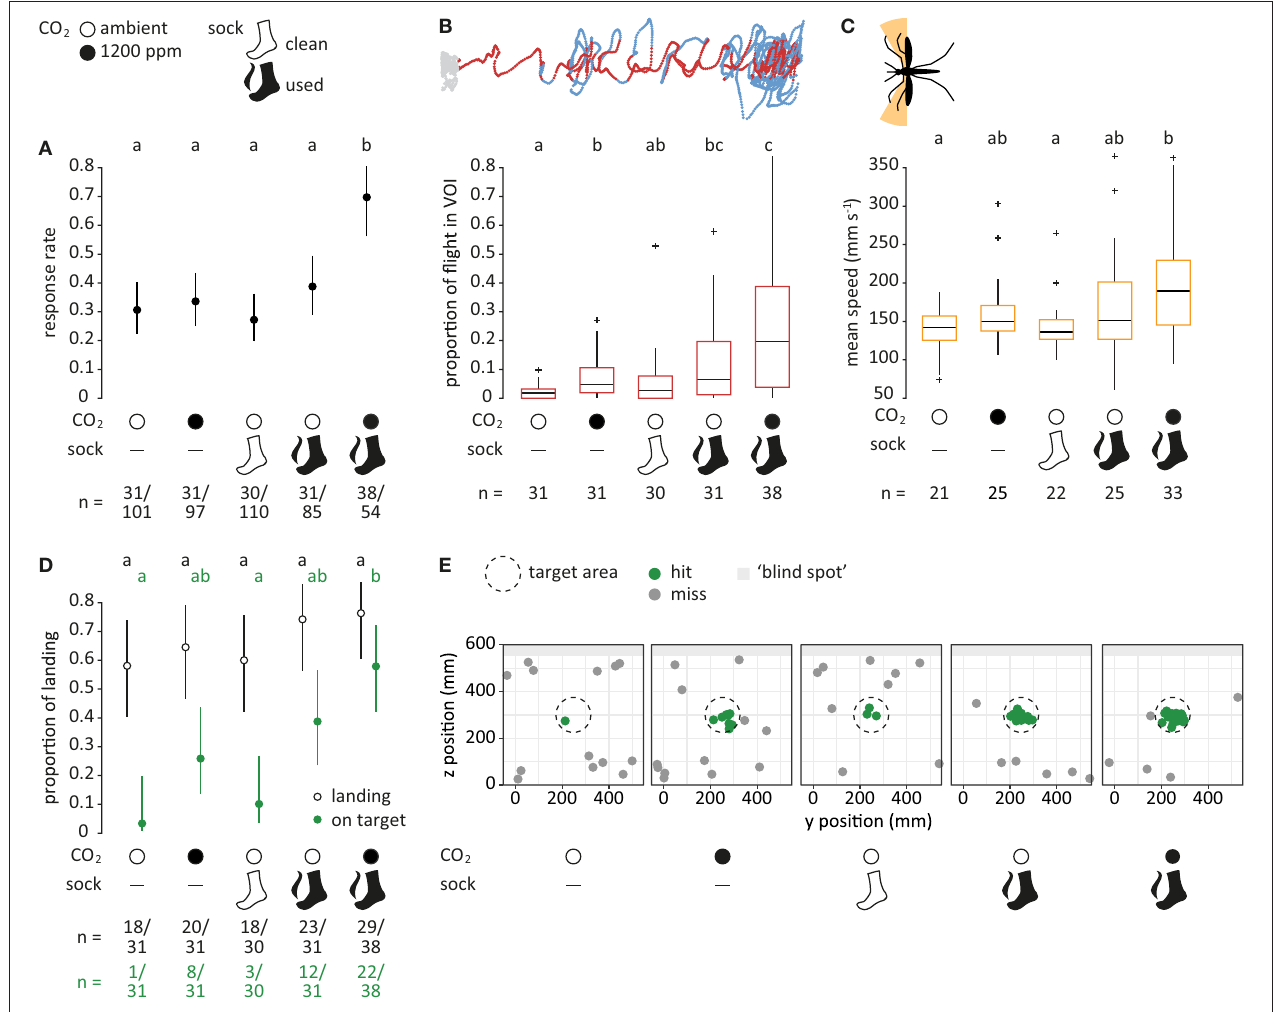
FIGURE 4 | Mosquito flight in response to human host cues. (A) Proportion of mosquitoes responding (dots), i.e., entering the filmed volume within 3min, for each treatment. Bars denote 95% confidence intervals. Different letters denote significant differences between the treatments (pairwise comparison using “emmeans,” corrected with the Tukey method). Sample sizes are given below the plot. (B) Proportion of flight in volume of interest (VOI), as shown in dark red in the top panel (see Figure 3C ). Boxes represent upper and lower quartiles, whiskers denote 1.5 times interquartile distance, crosses outliers, and black horizontal lines the median. Different letters denote significant differences between the treatments (Dunn Kruskal-Wallis pairwise comparison test, Benjamini-Hochberg corrected). (C) Mean speed of crosswind flight for heading angles between 90 ◦ to 120 ◦ and 240 ◦ to 270 ◦ (orange area in the top panel). Only mosquitoes that were within the VOI at least once were taken into account. (D) Proportion of mosquitoes landing (black, open) and of mosquitoes landing on the target (green, filled) relative to the total number of responsive mosquitoes. (E) Landing location on the upwind screen. The defined target area (ø 15cm) is denoted as a dashed circle. Green dots indicate landing positions within, and gray dots positions outside of the target area. Light gray area denotes the “blind spot” where tracking of landing was not